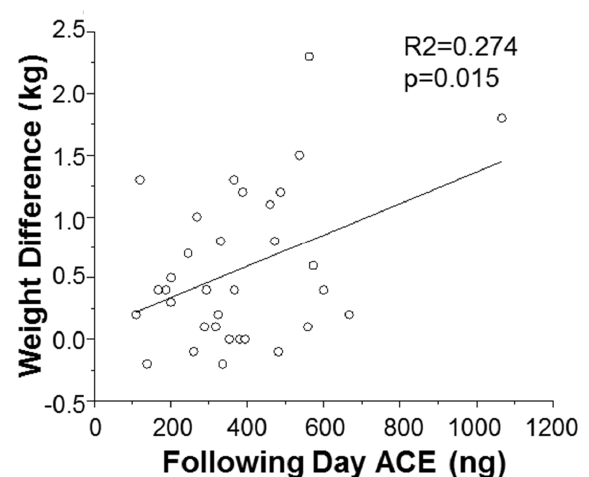
Figure 4. ACE as an early biomarker for weight loss in individuals with a BMI ≥ 25. Plot of following day ACE against weight difference. R 2 = 0274 and p = 0.015.